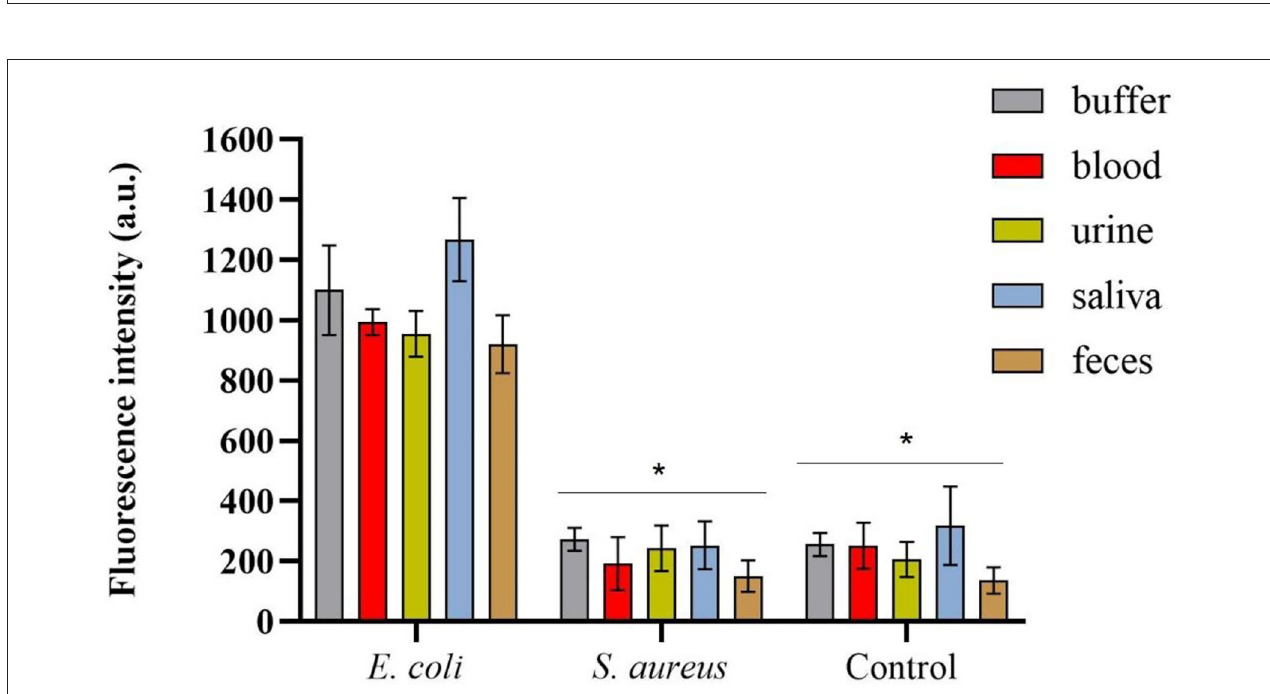
FIGURE 5 | Spectrofluorimetric results of the magnetic sandwich assay performed in the different types of human specimens for E. coli HB104 (used as target bacteria), S. aureus HB22 (used as non-target bacteria), and for the control without bacteria added. Errors bars represent the standard deviation of the average of three measurements in the three independent assays ( n = 3). *Statistical analysis was done comparing the signals in each of the human specimens obtained for S. aureus and control (without bacteria) with the signal of E. coli (target bacteria), defined as “positive” control, in the same samples. Multiple comparisons were done using the two-way ANOVA test ( p -value < 0.0001) followed by Dunnett’s multiple comparison test ( p -value < 0.0001). a.u. stands for arbitrary units.